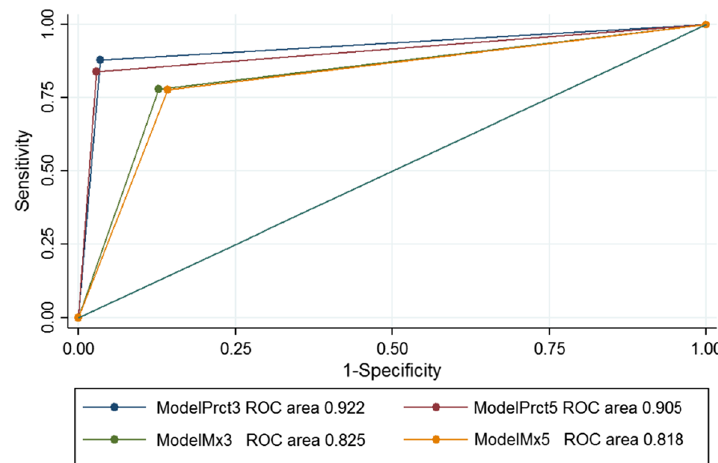
Fig. 3 Pneumonia ROC curve in the training set